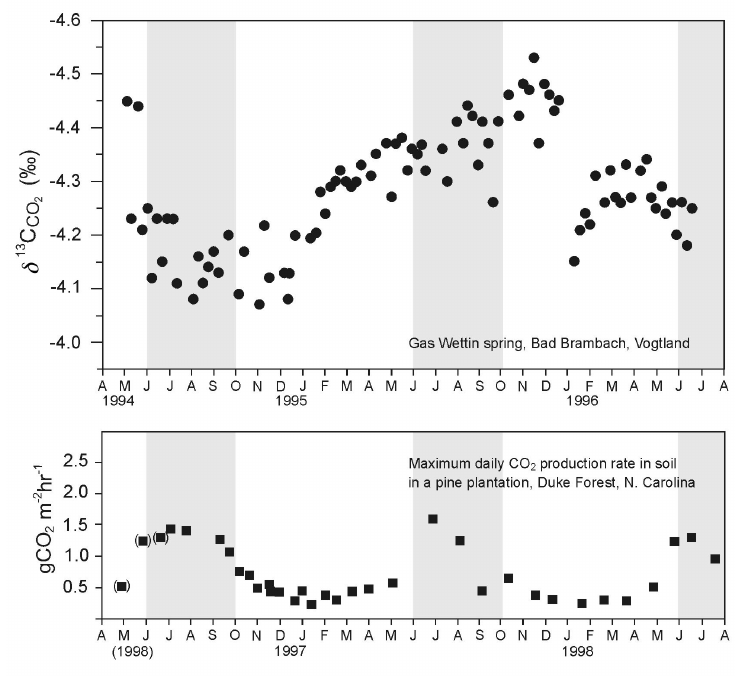
Fig. 10. Long-term observation of isotopic composition of the gas of the Eisen spring in Bad Brambach, Eger Rift (Weise et al ., 2002) and typical annual changes in the CO 2 production in soils (Andrews and Schlesinger, 2001). Growing seasons – light